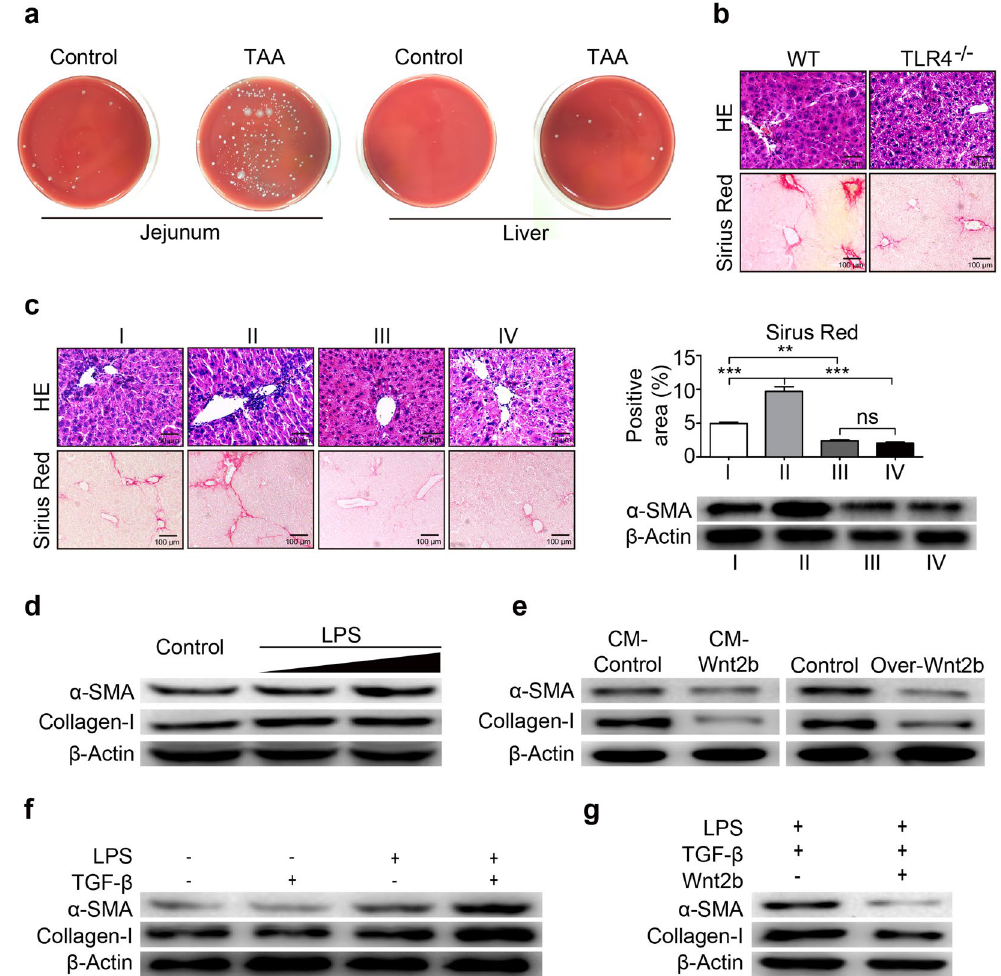
Figure 5. Wnt2b suppresses TLR4 activation-mediated pro-fibrogenic effects. ( a ) Representative images for bacterial growth of jejunum (left) and liver tissues (right) after cultivation on Blood Agar Plates. ( b ) Representative H&E (upper) and Sirius Red staining (lower) of liver tissues from WT mice and TLR4 − / − mice after 12 intraperitoneal injections of TAA. ( c ) H&E and Sirius Red staining,Western blotting of α -SMA in liver tissues from mice treated with TAA alone, or combined with sh-Wnt2b construct/TLR4 inhibitor TAK242 (4 mg/kg, i.p.), or all of the three factors given above in combination for 4 weeks. ( d ) Protein levels of α -SMA and Collagen-I in LX2 cells stimulated with LPS (10, 100 ng/ml) for 24 h. ( e ) Effects of Wnt2b on the α -SMA and Collagen-I expressions in LX2 cells stimulated with LPS (100 ng/ml). ( f ) Protein levels of α -SMA and Collagen-I in LX2 cells stimulated with LPS (100 ng/ml) or vehicle for 24 h, and TGF- β (500 pg/ml) or vehicle for an additional 48 h. ( g ) LX2 cells were transfected with active Wnt2B-V5 or control plasmids for 24 h, followed by treatment with LPS ± TGF- β as described in Fig. 5f. The expression of α -SMA and Collagen-I were then detected by Western blot analysis. Cropped blots are displayed; Full-length blots are presented in Supplementary Fig. S7. Statistical analysis provided the mean ± SE (n = 6/group), * P < 0.05, ** P < 0.01, *** P <